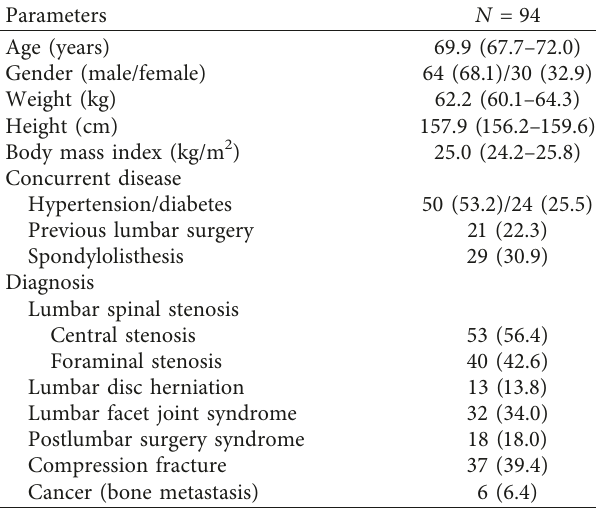
Table 1: Baseline characteristics of the study